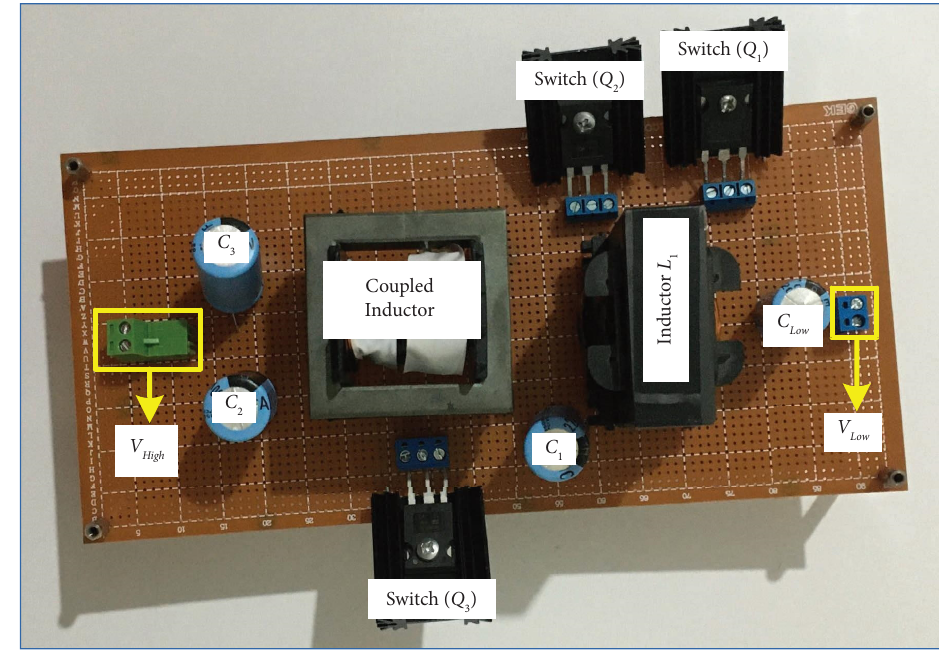
Figure 9: Experimental prototype of the suggested converter.